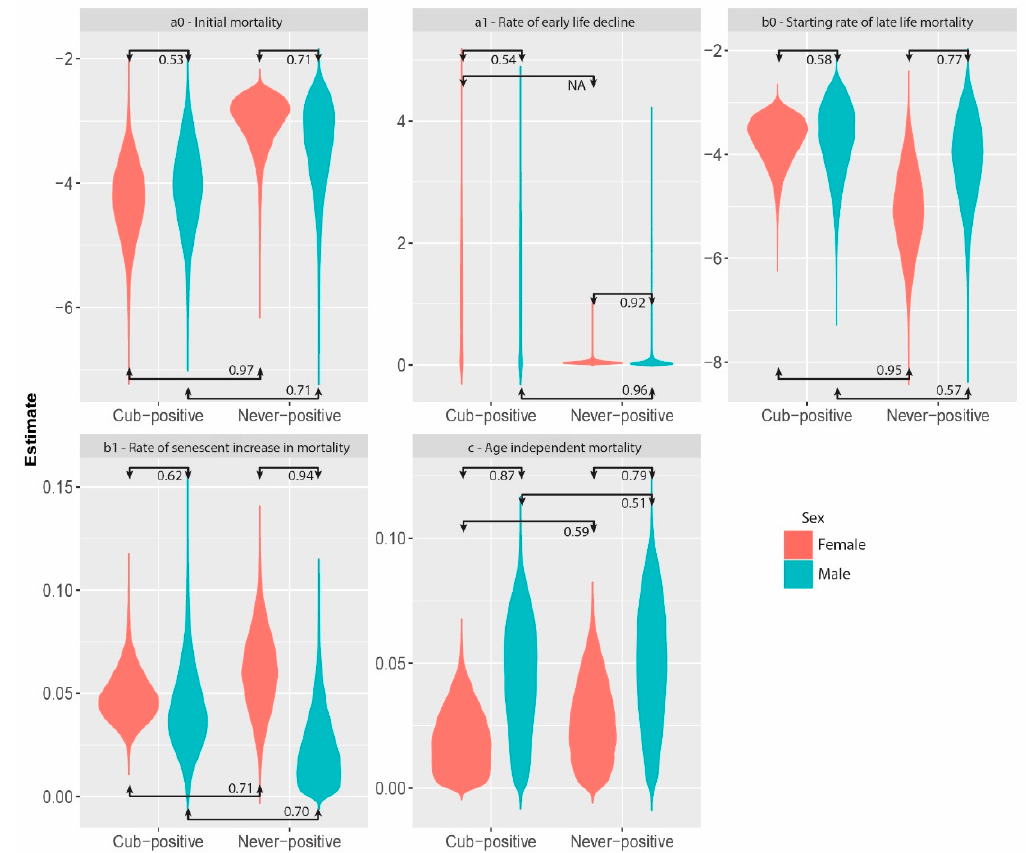
Figure 3. Posterior distributions of mortality trajectory parameter estimates for a population of wild European badgers naturally infected with bovine tuberculosis. Female (red) and male (blue) posterior distributions of mortality parameters of the Siler function, split by infection status. “Cub-positive” refers to individuals who tested positive in the first year of their life. “Never-positive” refers to individuals who never tested positive throughout their lives. Adapted Kullback–Liebler discrepancy measures are shown in black, indicating the degree of distribution overlap between classifications of sex and disease status. Measures over 0.65 are considered important (0.5 = distributions are identical, 1 = no overlap). Iterations = 1,000,000; burn in = 10,001; thinning = 200; number of chains = 4. (For table of estimates and 95% confidence intervals, see Table S1).